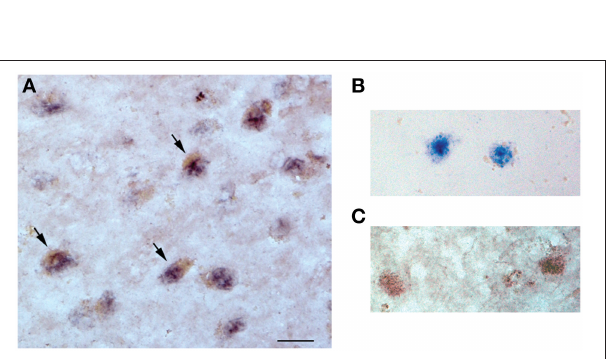
FIGURE 3 | miR-23a and sirt1 co-localize in the nucleus of frontal cortex layer III neurons. Dual in situ hybridization/immunohistochemistry of miR-23a RNA and sirt1 protein expression was performed in frontal cortex of an 87 year-old female subject who died with a clinical diagnosis of aMCI. (A) Photomicrograph shows layer III neurons co-labeled with miR-23a labeling (dark purple) and sirt1 (brown, arrows). Note that miR-23a appears localized to the nucleus, whereas sirt1 labeling is nuclear but also with immunoreactivity in the cytoplasm. (B) Dual miR-23a/sirt1 detection in the absence of sirt1 primary antibody (anti-rabbit IgG only). (C) Dual miR-23a/sirt1 detection with control scrambled miRNA probe. Scale bar = 30 µ